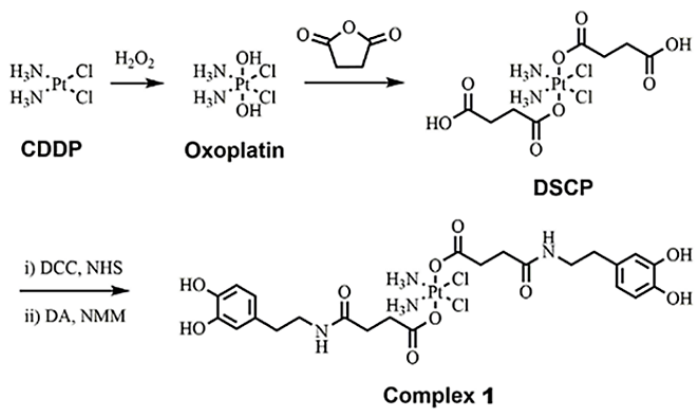
Scheme 1. Synthetic route of complex 1 .